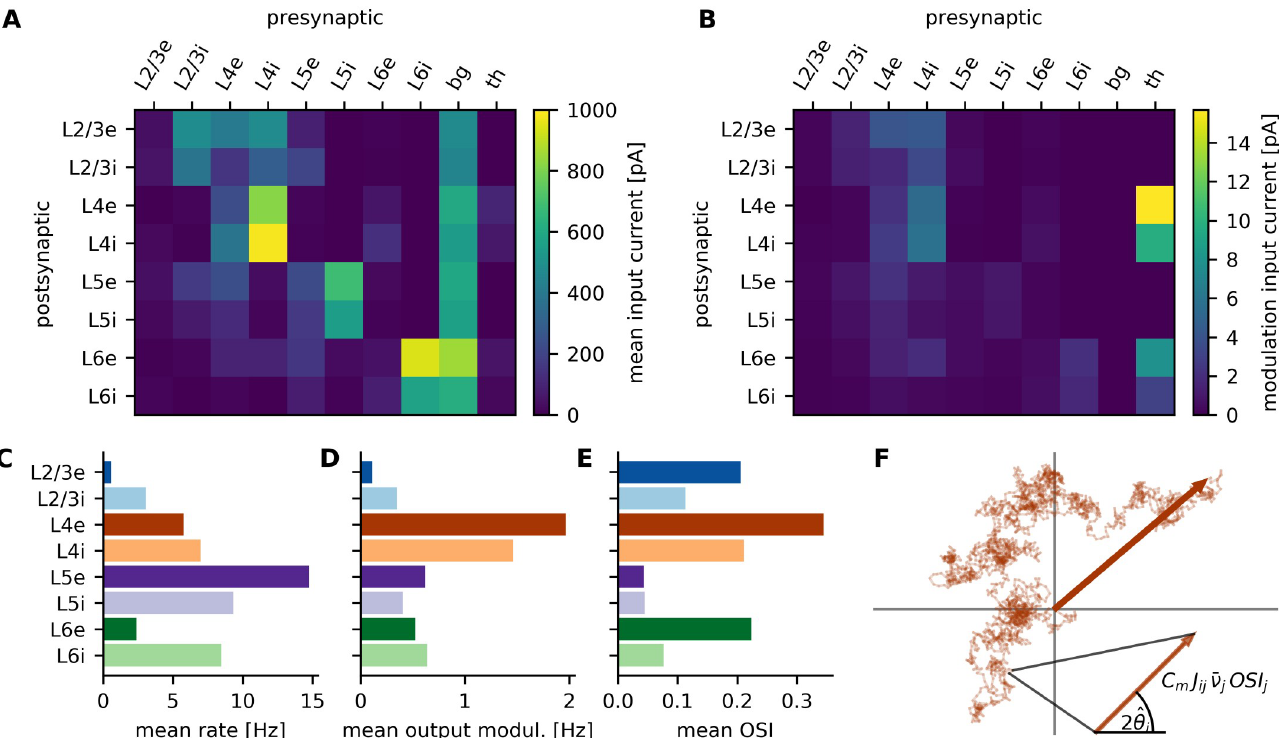
Fig 5. Neuronal input analysis. A Mean input currents for all projections between all the involved neuronal populations. B Mean projection tuning vector length for all recurrent projections (see text for explanation). C-E Output firing rates (F0 of tuning curves), output modulations (F1 of tuning curves) and resulting OSI, averaged over each population. F Illustration of single neuron input tuning vector addition. Each small arrow represents the tuning vector of a single pre-synaptic neuron. Linearly adding the vectors of all pre-synaptic neurons of one population results in the tuning vector that characterizes the projection to one post-synaptic